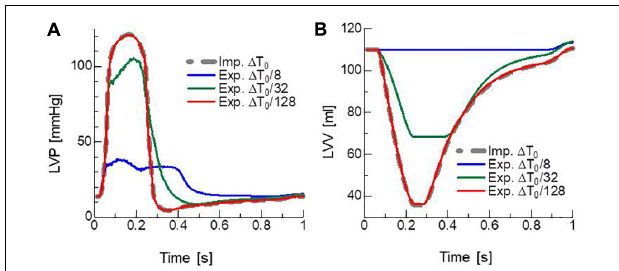
FIGURE 6 | Time transients of (A) left ventricular pressure (LVP) and (B) volume (LVV) obtained by the MusAsi with the FE time step size (cid:49) T = (cid:49) T 0 (thick gray broken lines) and the explicit active tension approach with the finer time steps (cid:49) T = (cid:49) T 0 / 8 (blue lines), (cid:49) T 0 / 32 (green lines), and (cid:49) T 0 / 128 (red lines).